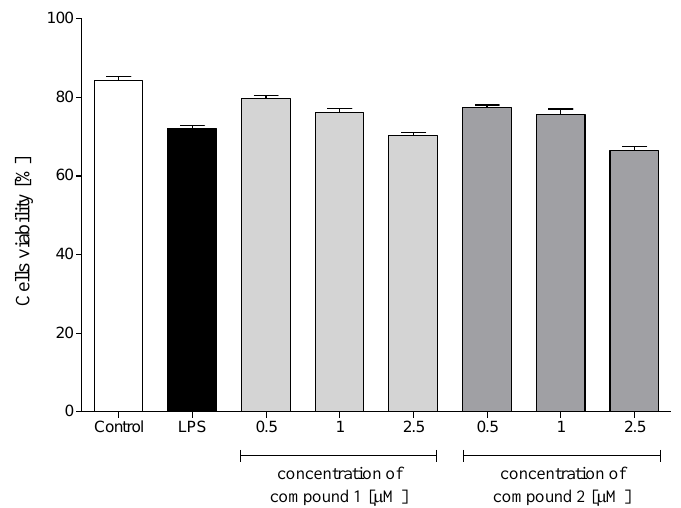
Figure 4. Cytotoxic effects of 1 (4β,8α-dihydroxy-5β-angeloyloxy-9β-(2-methylbutyryloxy)-3-oxo- germacran-6α,12-olide) and 2 (cardivarolide G), at concentrations 0.5, 1.0 and 2.5 μM, on human LPS-stimulated neutrophils. Results shown as percentage of cells without diminished membrane integrity (propidium iodide negative cells). Control, untreated cells; LPS, cells stimulated with LPS (stimulated control). Statistical significance: * p < 0.05, with reference to a stimulated control.